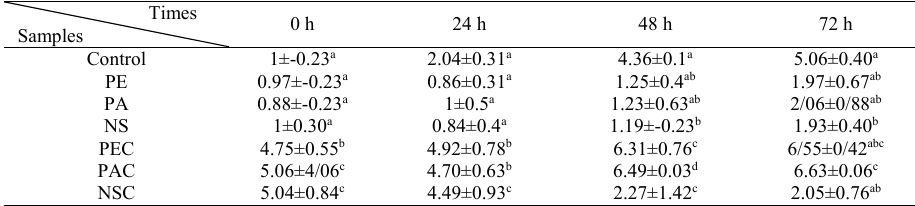
Table 3. Comparing mean and standard deviation logarithm of 7 treatments (mentioned packages) of total bacteria count in four hours (Zero, 24, 48 and 72) PE (Polyethylene), PA (Polyamide), NS (Nano-silver), PEC (Polyethylene Contaminated), PAC (Polyamide Contaminated), NSC (Nano-silver Contaminated)